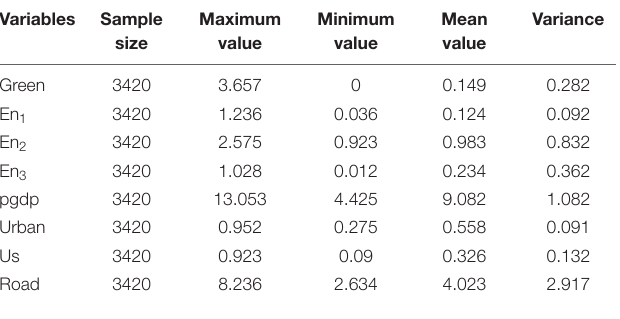
TABLE 1 | Descriptive statistics of the selected variables.